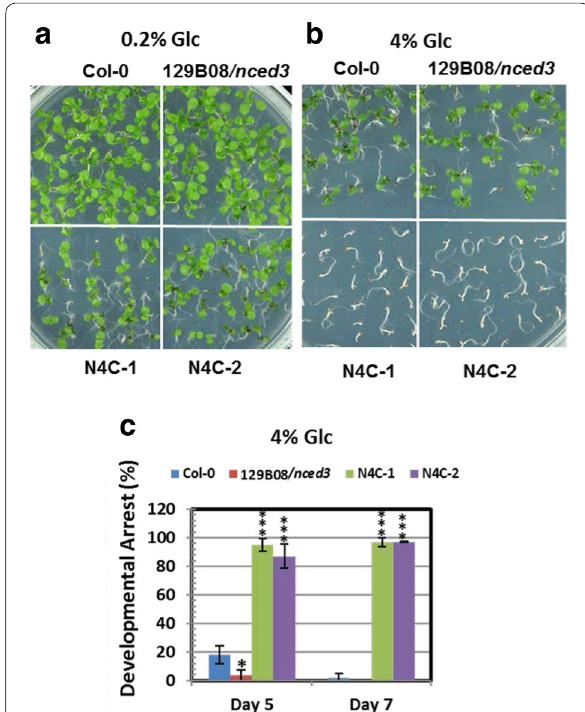
Fig. 4 Heterologous expression of rice OsNCED4 induced post‑ germination developmental arrest under high glucose condition. a Col‑0, 129B08/ nced3 mutant, and N4C‑1 and ‑2 transgenic seedlings grown on agar medium supplemented with 0.2% Glc for 7 days. b Col‑0, 129B08/ nced3 mutant, and N4C‑1 and ‑2 transgenic seedlings grown on agar medium supplemented with 4% Glc for 7 days. c The percentage of seedlings displaying post‑germination developmental arrest at 5 and 7 days after plating on media containing 4% Glc. The values are the mean SD of three independent experiments, each ± with 80–100 seeds. * P < 0.05; *** P < 0.001, Student’s t